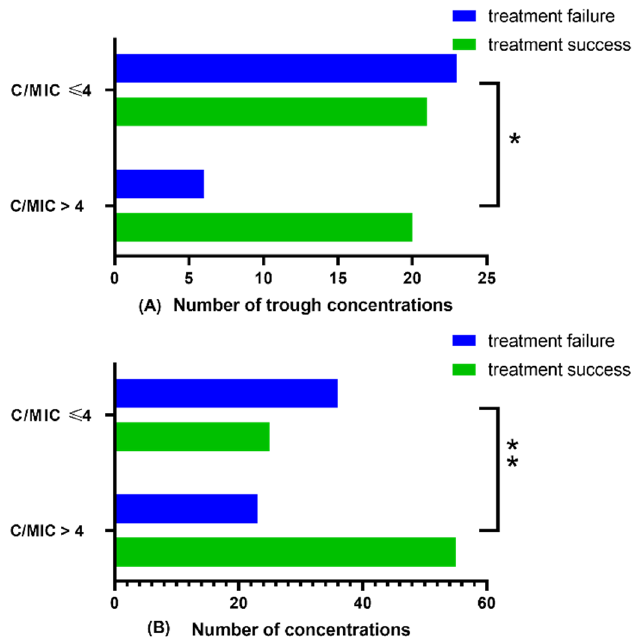
Figure 3. Distinction of treatment outcome in different groups of C trough /MIC and C/MIC. ( A ) Num- ber of trough concentrations ( n = 70), ( B ) Number of concentrations ( n = 139). C trough , trough meropenem concentration; C, overall meropenem concentration; MIC, minimum inhibitory concen- tration; * represents p < 0.05, ** represents p <